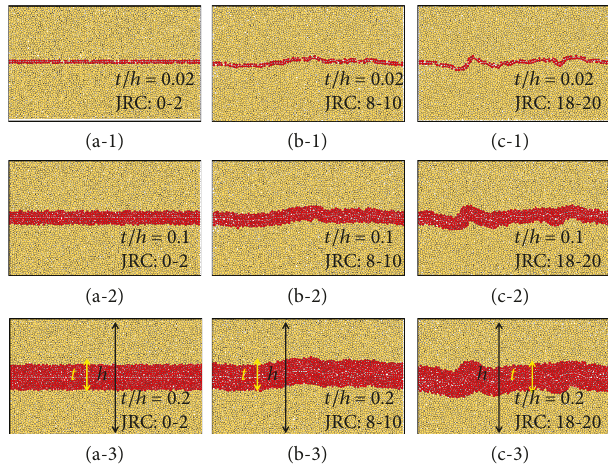
Figure 4: Typical in fi ll distributions of the simulated specimens. (a-1) – (a-3) Specimens with an equal JRC of 0 – 2 and in fi ll thickness ratios ( t/h ) of 0.02, 0.1, and 0.2, respectively. (b-1) – (b-3) Specimens with an equal JRC of 8 – 10 and t/h of 0.02, 0.1, and 0.2, respectively. (c-1) – (c-3) Specimens with an equal JRC of 18 – 20 and t/h of 0.02, 0.1 and 0.2, respectively.